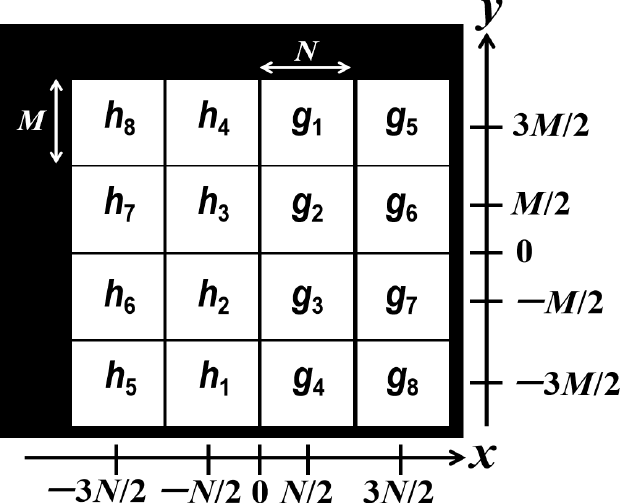
Figure 1. Data distributions placed at the input plane of the JTC for the p = 8 grayscale images to be encrypted. The values of a j and b j with j = 1,2, . . . ,8 for this figure are a 1 = a 2 = a 3 = a 4 = N /2, a 5 = a 6 = a 7 = a 8 = 3 N /2, b 1 = b 5 = 3 M /2, b 2 = b 6 = M /2, b 3 = b 7 = − M /2 and b 4 = b 8 = − 3 M